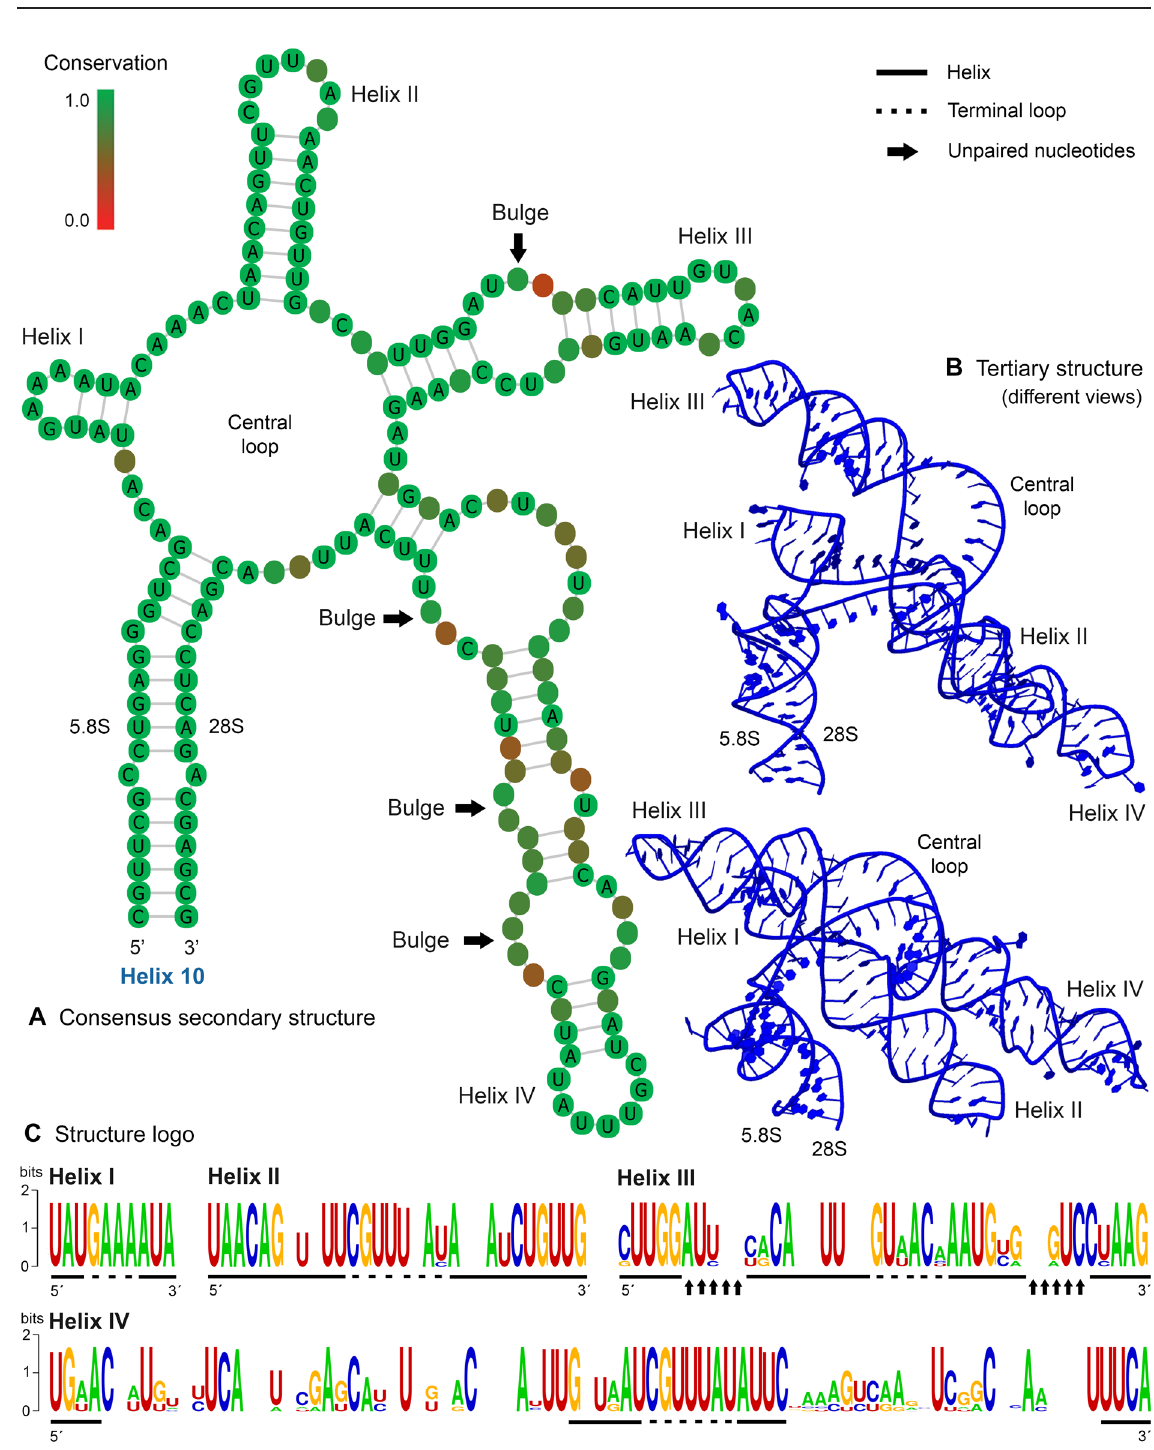
Fig. 6. ITS2 of the subgenus Hystricochaetonotus Schwank, 1990. A . Putative consensus secondary structure. The central loop radiates four unequally long helices. The first two helices are highly conserved, while the two following helices are much less conserved. For localization of helix 10, which is made by the interaction of 3’-end of 5.8S and 5’-end of 28S, see Fig. 7. B . Two different views on the tertiary structure, showing that helices II and IV run in parallel. C . Structure logos of helices I‒IV. The height of a base is proportional to its frequency in the multiple sequence